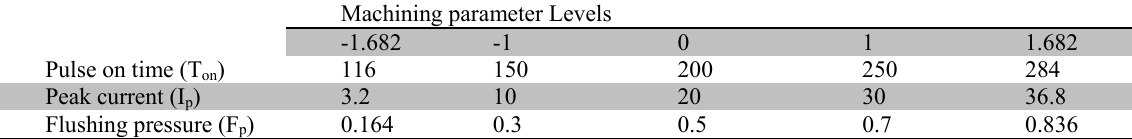
Process parameter and their levels